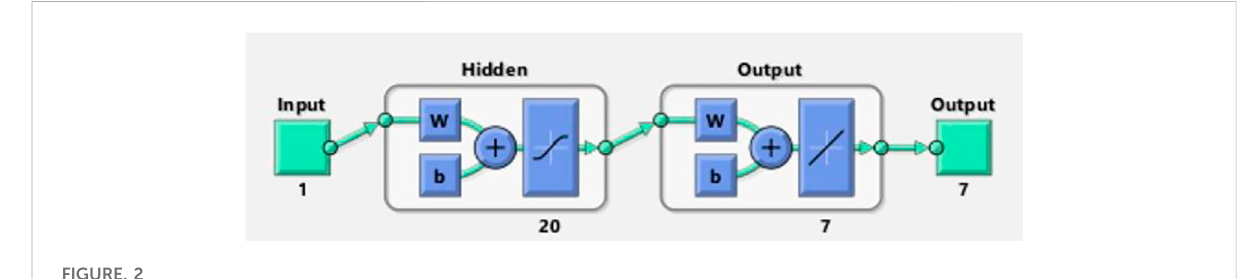
FIGURE. 2 Neural networks for